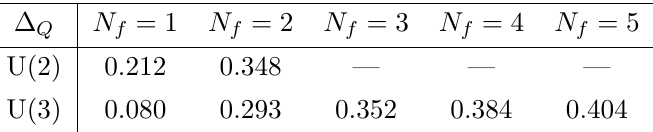
Table 10 . The IR R -charge of the fundamental field Q of the double adjoint theory without the monopole superpotential [48]. The values for U(2) with N 3 are absent because Tr X 4 is irrelevant f ≥ in those cases, which were thus excluded for the original HKP duality [48] for the double adjoint theory without the monopole superpotential.